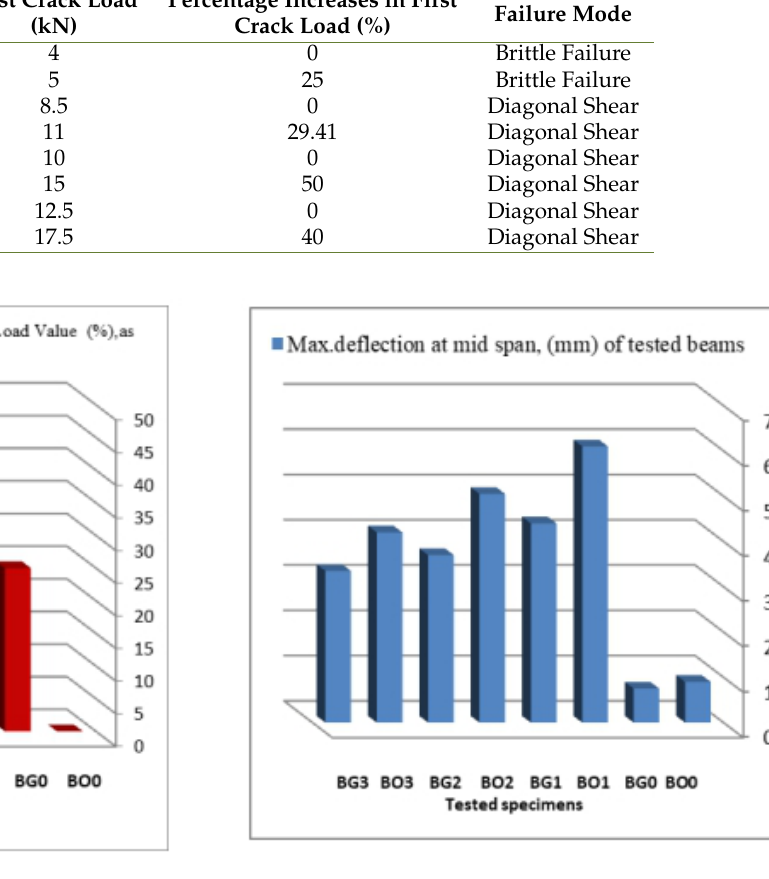
Fig. 12. First Crack Load Value for Tested Beams this